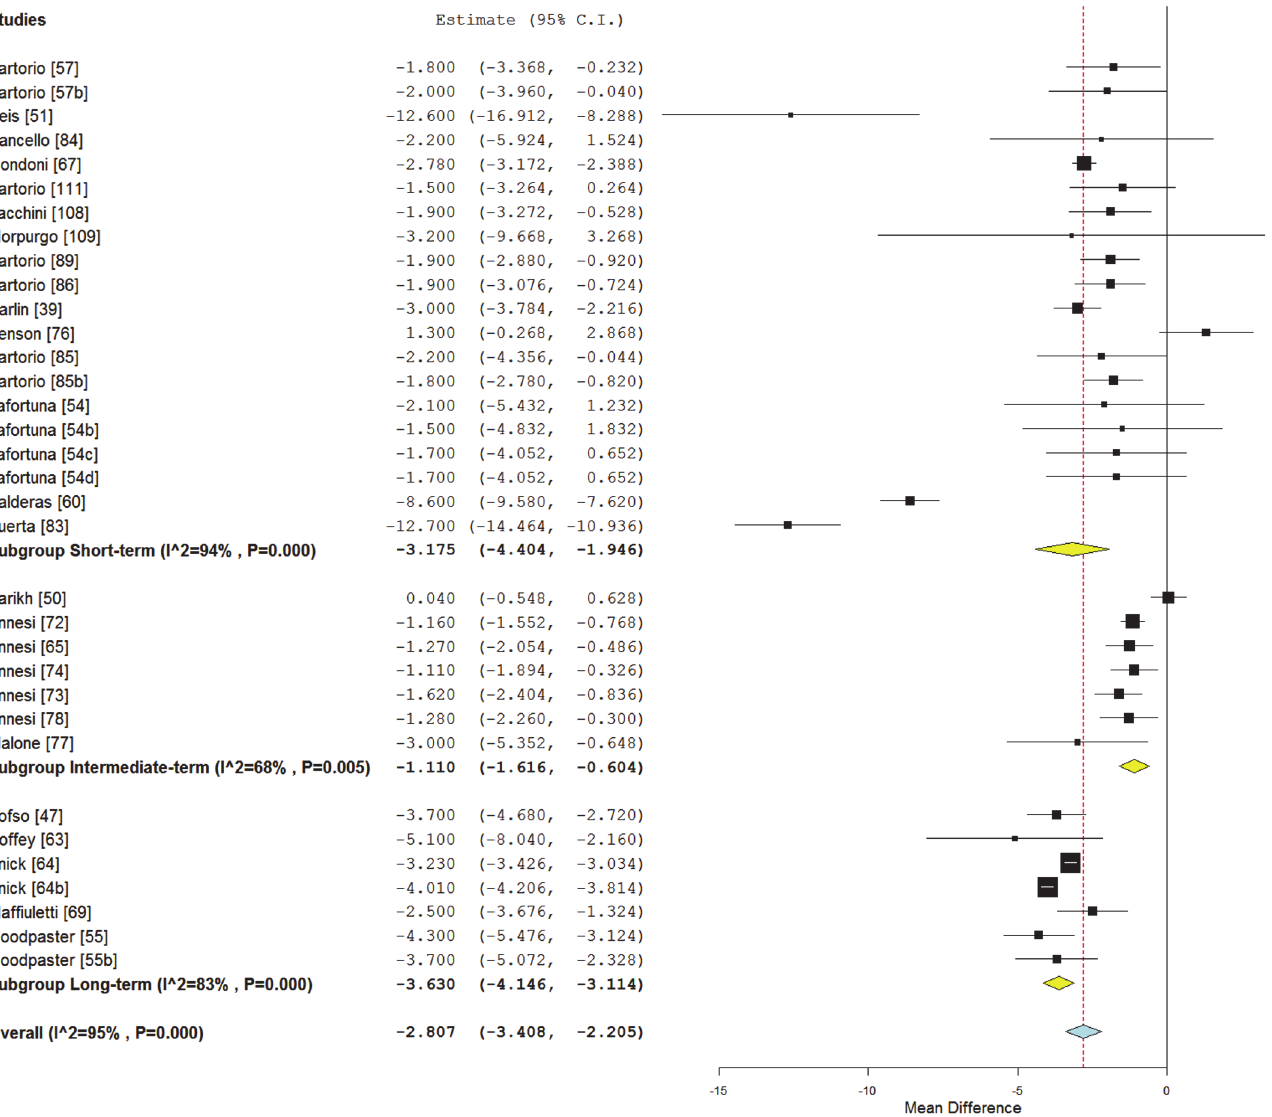
Fig 2. Forest plot of mean body mass index changes according to the intervention length in class II and III obese